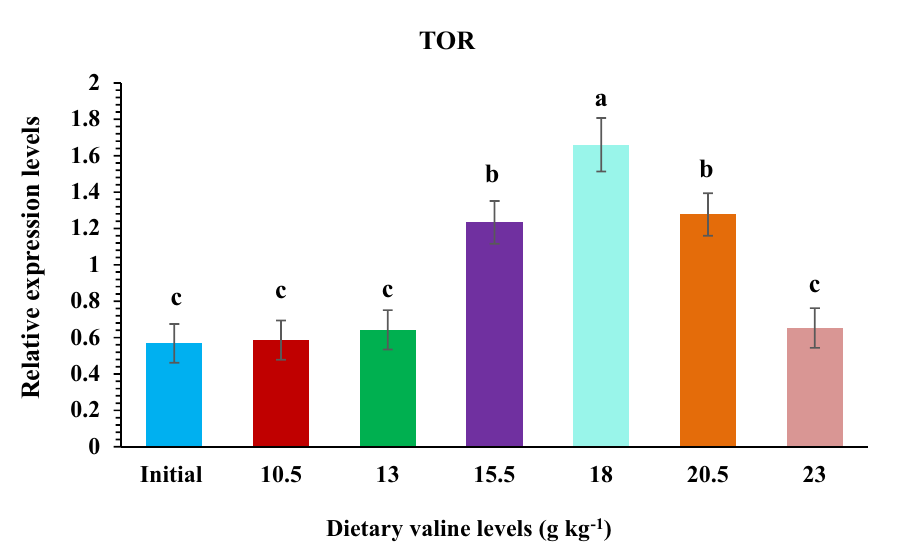
Figure 5. Relative expression level of target of rapamycin (TOR) gene in the muscle of rainbow trout, Oncorhynchus mykiss fingerlings fed varied dietary Val levels (g kg −1 ).